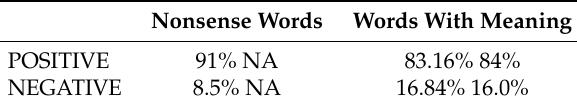
Table 4. Speech/facial movements synchronization.